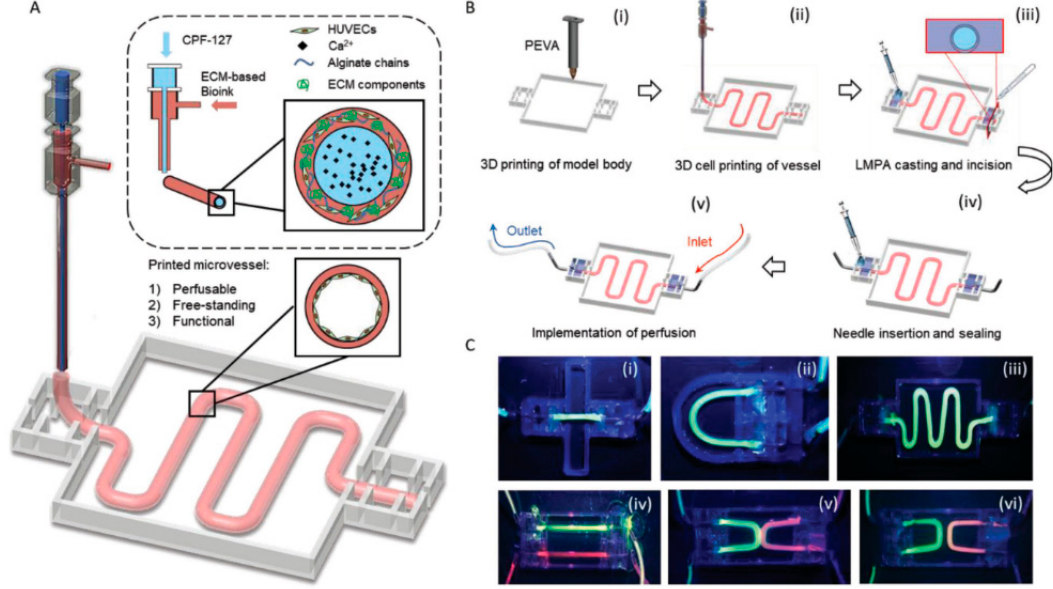
Figure 2. Bioprinting system for ECM-based bioink with a core of Pluronic and calcium ions and a shell of HUVECs encapsulated in alginate and ECM components ( A ). Di ff erent steps in the fabrication of the vascular model ( B ): (i) 3D printing of the PEVA model body; (ii) the 3D cell printing; (iii) casting and incision of low melting point agarose; (iv) needle insertion and sealing; and (v) perfusion. Perfusion of vessels construct with di ff erent designs ((i) straight; (ii) curved; (iii) serpentine; (iv) dual-parallel; (v) attached dual-curves; and (vi) discrete dual-curves) ( C ). Reprinted from Reference [37] with permission from John Wiley and Sons.